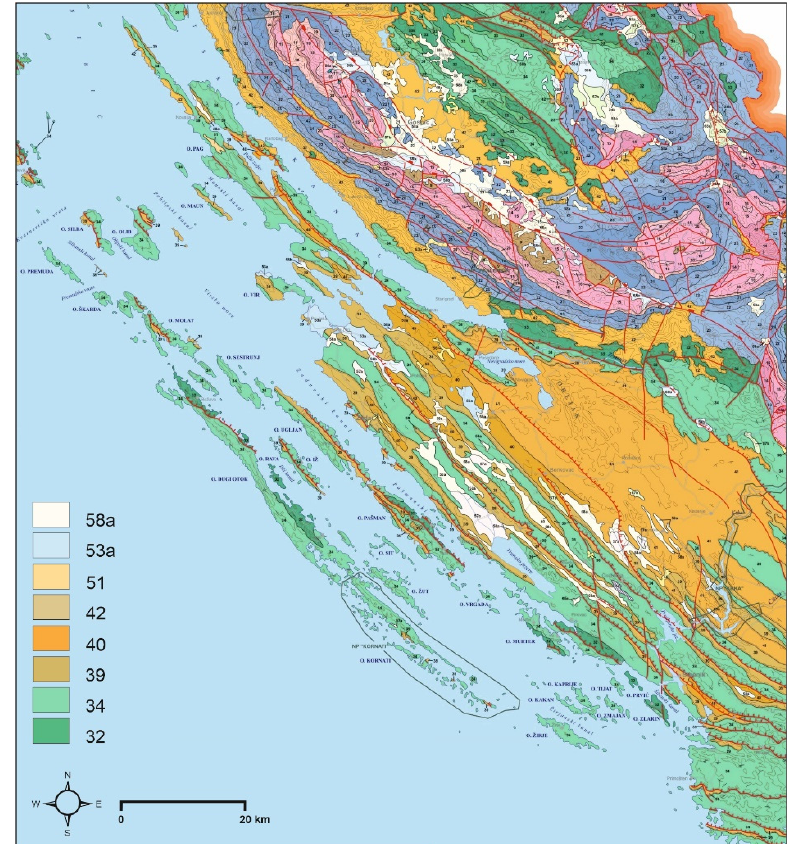
Figure 2. Excerpt from Geological Map of the Republic of Croatia, original scale 1:300,000, depicting the northern Dalmatian islands (explanation of numbers according to the map’s legend: 32—Lower Cretaceous dolomite, 34—Upper Cretaceous ore-bearing limestone, 39—Eocene Foraminifera limestone, 40—Eocene flysch deposits, 42—Paleogene-Neogene Limestone breccia, 51—Neogene deposits, 53a—Pleistocene fluvial deposits, 58a—Holocene diluvial and proluvial